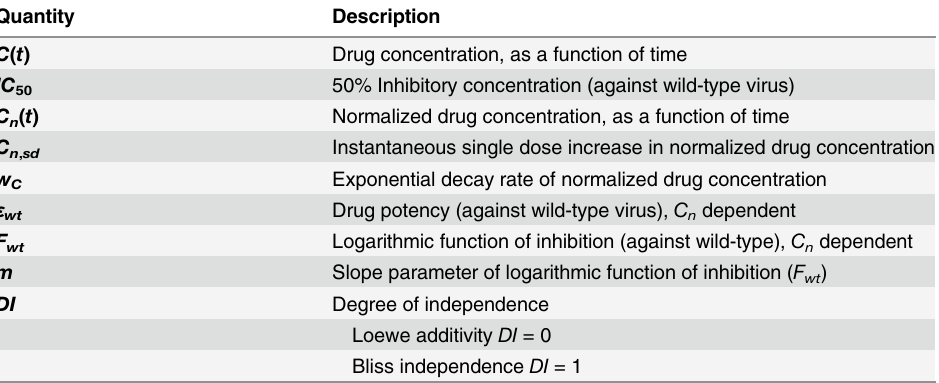
Table 4. Key PK/PD modeling